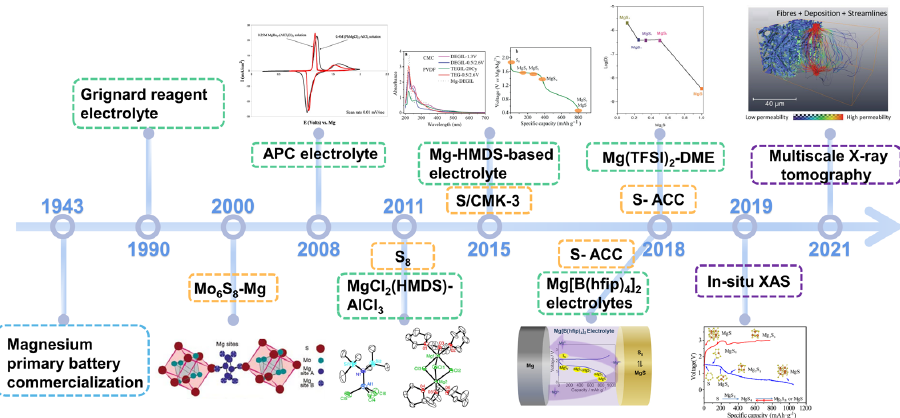
Figure 1. The history of RMB development beginning in 1943 in terms of electrolyte (green), cathode (orange), and characterization techniques (purple). Grignard reagent electrolytes [8]. Mo 6 S 8 as